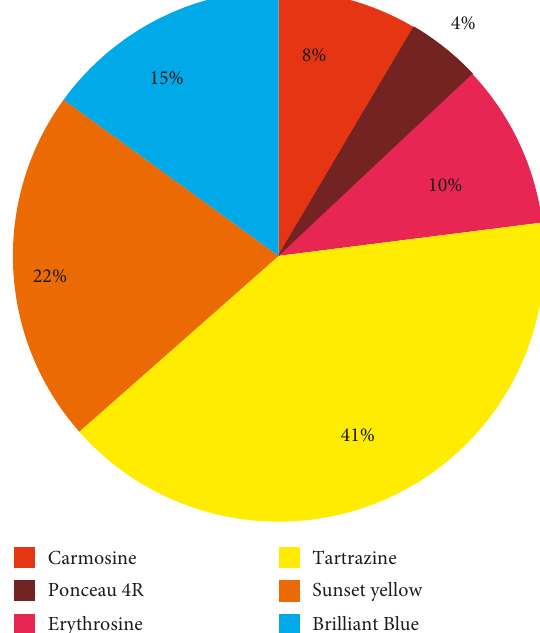
Figure 3: Distribution of food colours in confectionaries and beverages as